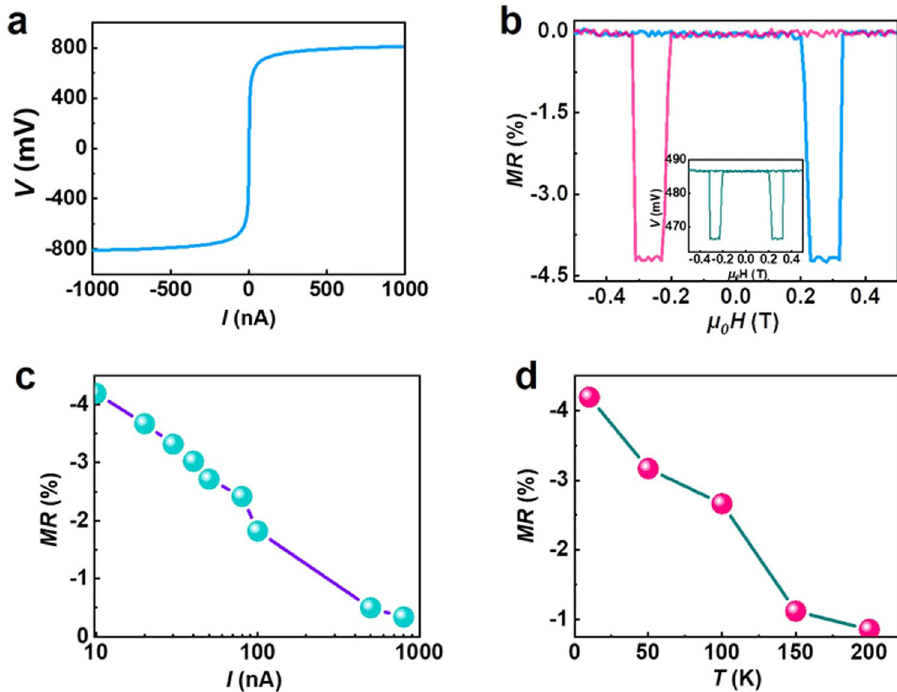
Fig. 2 Charge and spin transport behaviors of FGT/WSe 2 /FGT with 12-nm WSe 2 spacer. a The current – voltage curve of FGT/WSe 2 (12 nm)/ FGT spin valve at 10 K. b MR of the FGT/WSe2/FGT spin valve with I = 10 nA at 10 K. The inset shows the direct V – H curve of the device. c MR of FGT/WSe 2 /FGT spin valve with different bias currents. d MR of FGT/WSe 2 /FGT spin valve at different